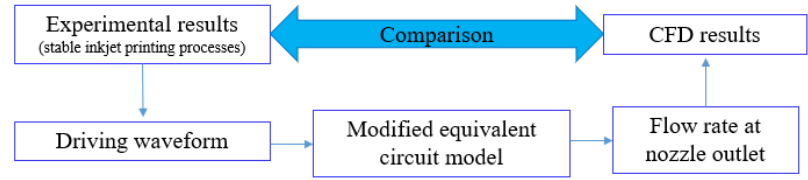
Figure 3. Verification approach of modified model.